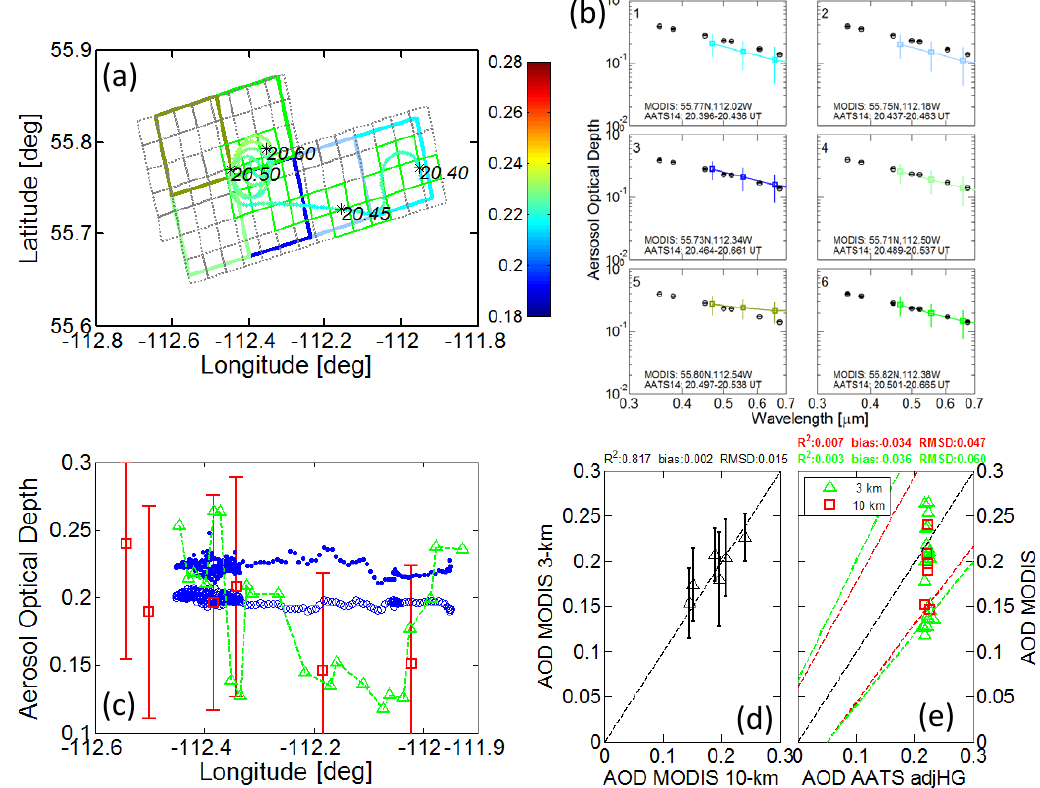
Fig. 10. Same as Fig. 9 but for the 3 July Aqua MODIS–AATS AOD Figure 10. Same as Fig. 9, but for the 03 July Aqua MODIS/AATS AOD comparison.